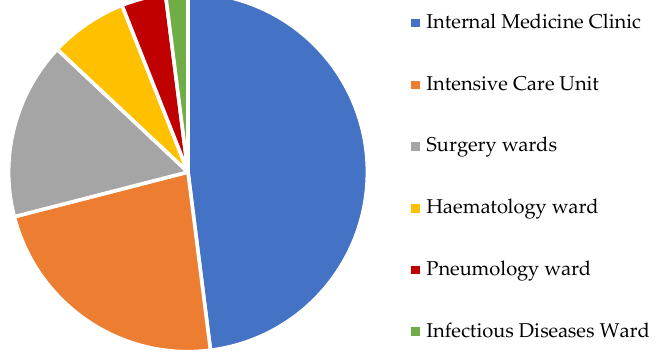
Figure 1. Isolates distribution among hospital wards.